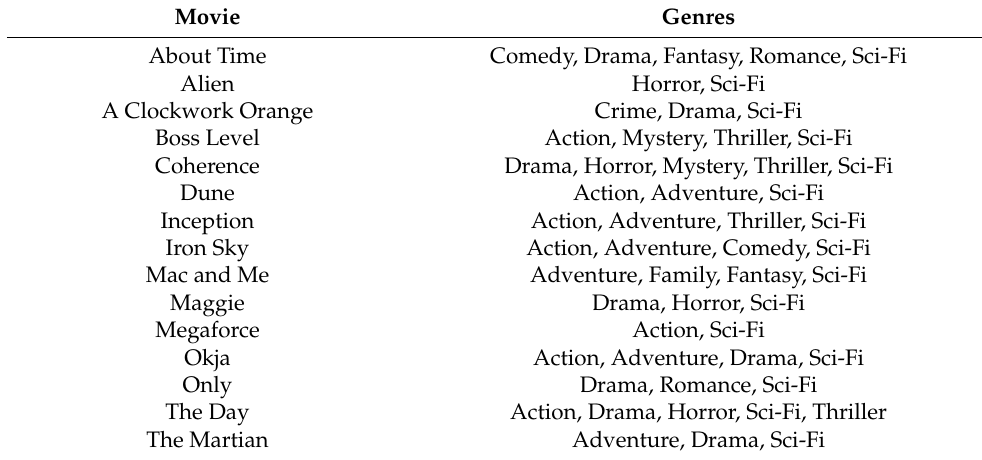
Table 1. Science fiction movies